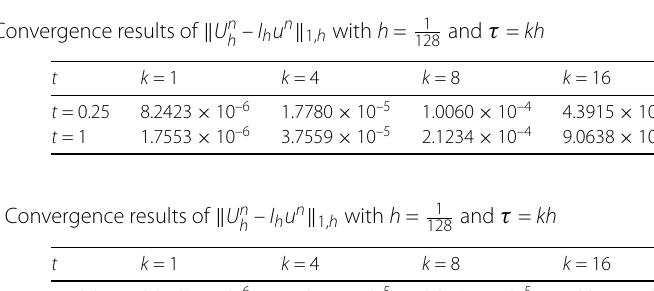
Table 9 Convergence results of (cid:7) U n